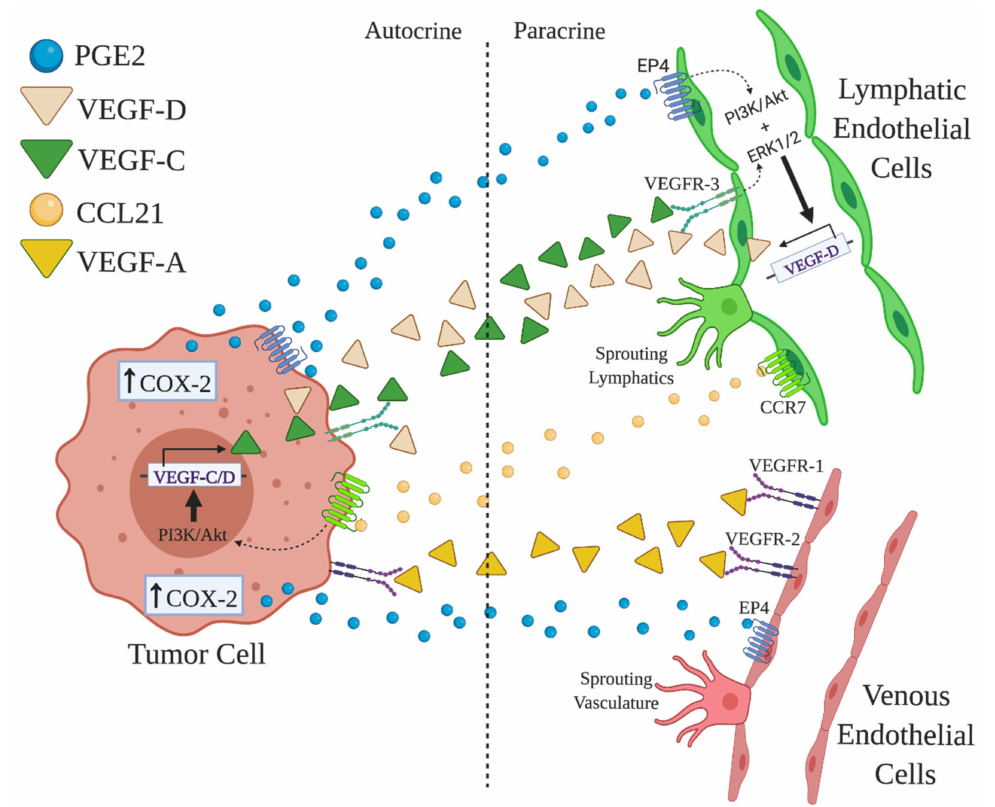
Figure 3. Tumor-associated angiogenesis (TAA) and lymphangiogenesis (TAL) and the proposed roles of PGE2/EP4. vascular endothelial cells (VEC) and LEC precursors located in venules and lymphatic capillaries bear respective receptors VEGF-R1, -R2 for VEGF-A and VEGF-R3 for VEGF-C and -D, respectively. They also bear PGE2 receptor EP4. The production of VEGF family and PGE2 by tumor cells or host cells such as macrophages (not shown) stimulates TAA and TAL by binding to their receptors on VEC or LEC. EP4 activation also induces CCR7 on LEC precursors, which binds to CCL21 produced by tumor or host cells. (Figure based on Tutunea-Fatan et al., 2015 [59] and Nandi et al., 2017